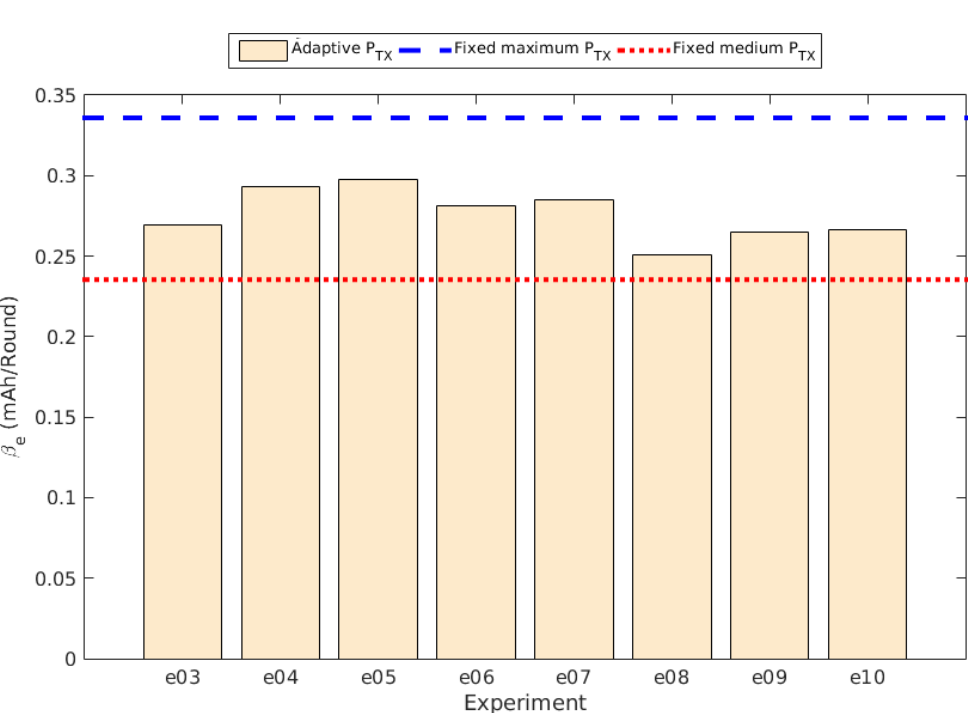
) comparison between experiments. e